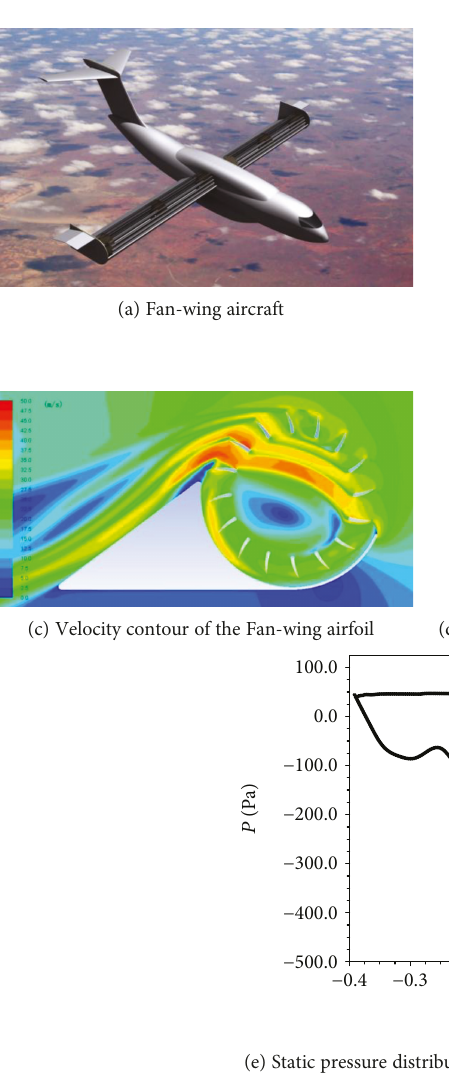
Figure 1: Introduction of the Fan-wing